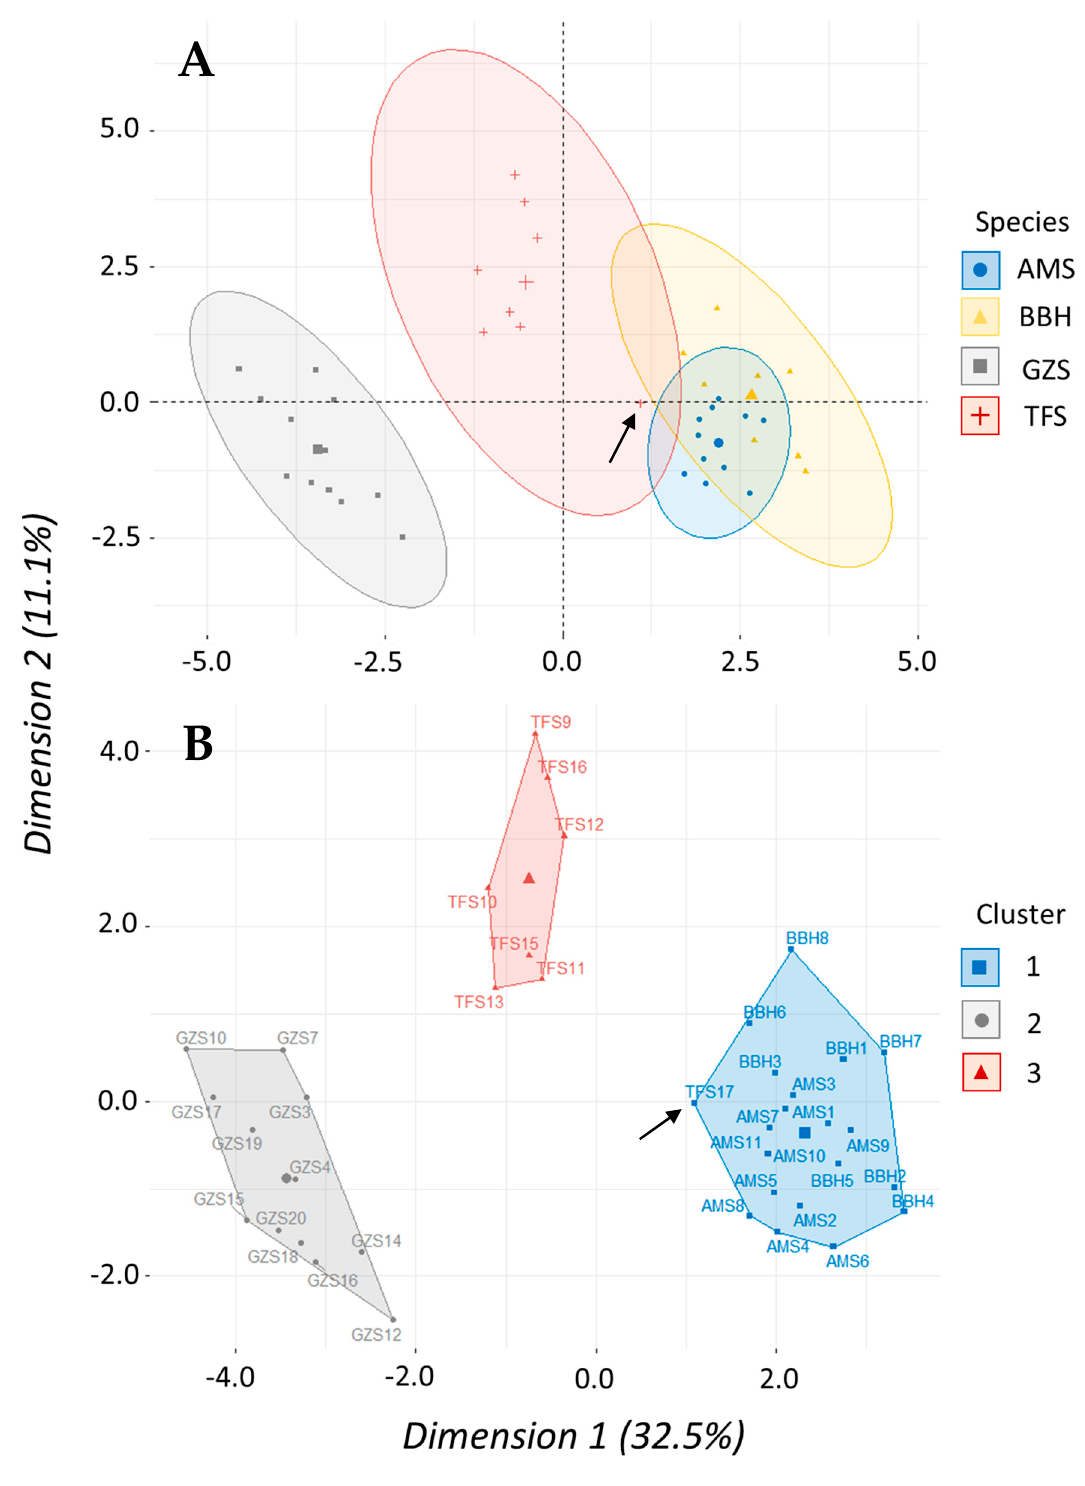
Figure 5. Initial results of the principal component analysis and hierarchical clustering on principal components using morphometric data collected from American (AMS), blueback (BBH), gizzard (GZS), and threadfin (TFS) shad. ( A ) Biplot showing ellipses encircling individual fish considered part of that group according to PCA. ( B ) Cluster factor map showing results of HCPC analysis that produced three clusters. Gizzard shad and threadfin shad #17 (black arrow) were all ~4.0 cm larger on average than other shad species so all gizzard shad and TFS17 data were removed from the final analysis to preclude the confounding effects of fish size.